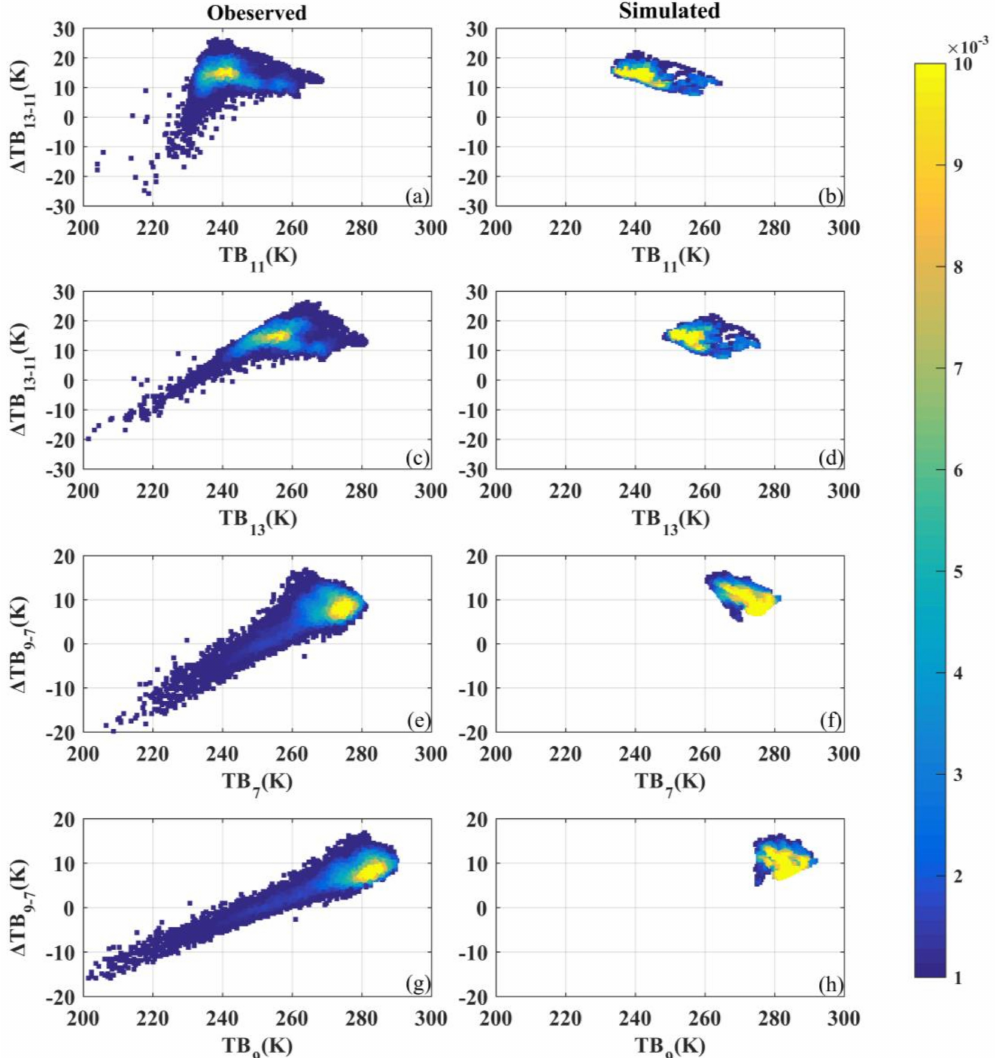
Figure 7. MWHS-2 observed (left column) and simulated (right column) joint probability density function (PDF) for ∆ TB 13-11 with TB 11 and TB 13 ( a – d ), as well as ∆ TB 9-7 with TB 7 and TB 9 ( e – h